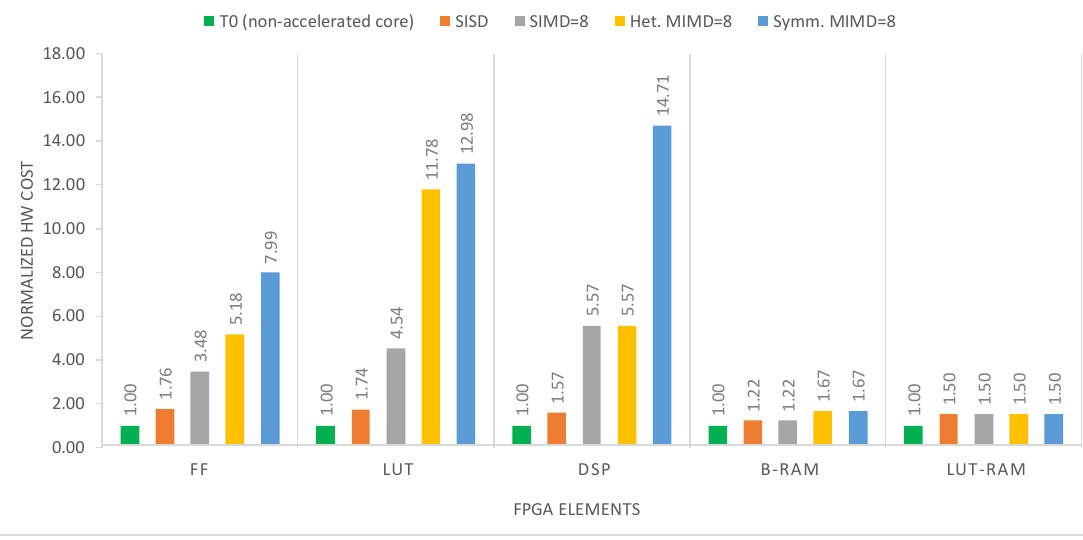
Figure 17. Hardware overhead normalized to the non-accelerated T0 core.